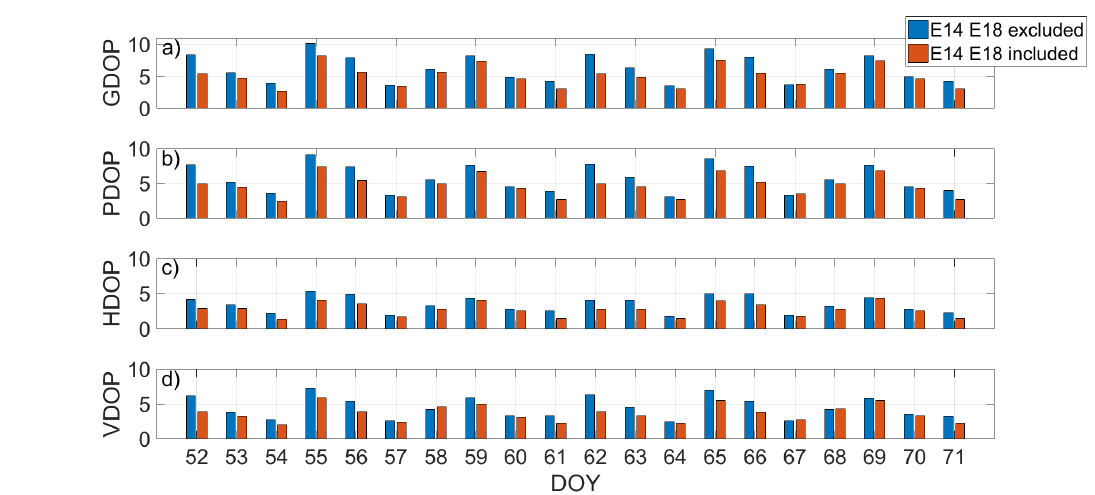
Figure 8. Daily dilution of precision comparison of the Galileo constellation in the YEL2 location excluding (blue bars) and including (red bars) the Milena (E14) and Doresa (E18) satellites. GDOP (Geometric Dilution Of Precision), PDOP (Position Dilution Of Precision), HDOP (Horizontal Dilution Of Precision), and VDOP (Vertical Dilution Of Precision) are compared in ( a – d ), respectively.